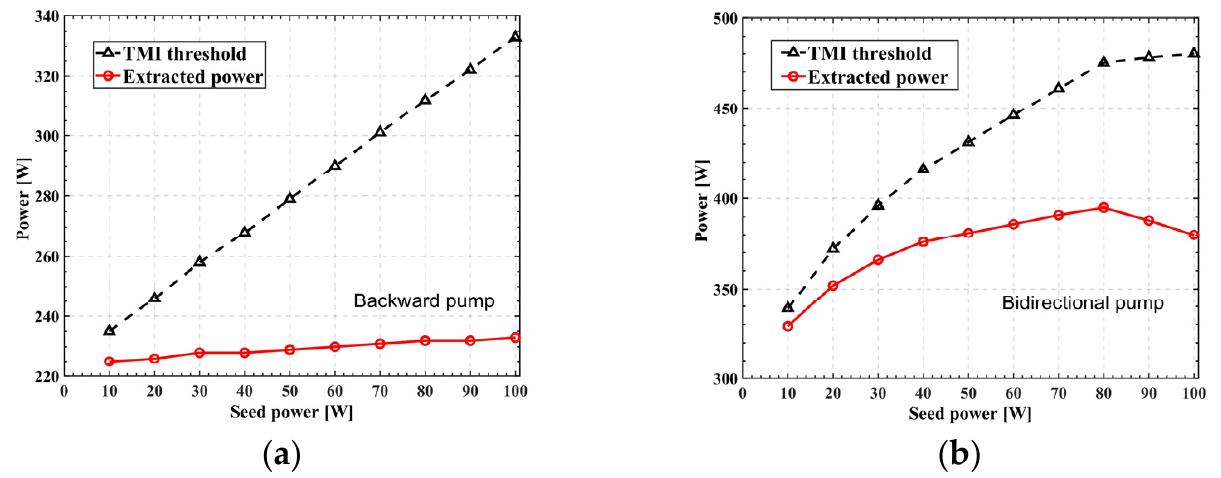
Figure 5. The TMI threshold and extracted power in ( a ) backward and ( b ) bidirectional pumped fiber amplifiers.